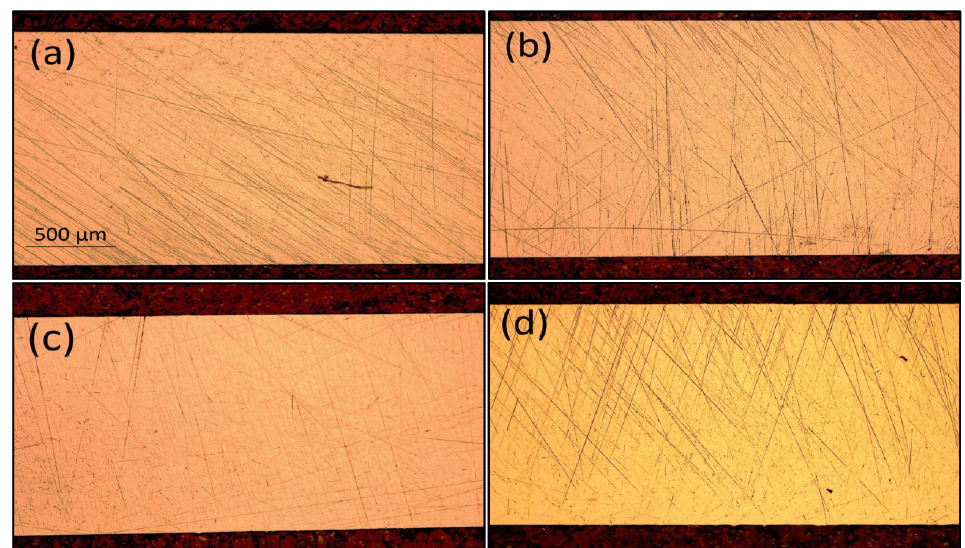
Figure 13. Optical microscope images of the cross-section of the titanium alloy sample (5 × magnifi- cation); ( a ) 1 cm from the inlet end of sample 1, ( b ) 3 cm from the inlet end of sample 1 in the first reactor, ( c ) In the middle of sample 5 in the second reactor and ( d ) 1 cm from the outlet end of sample 9 in the third reactor.